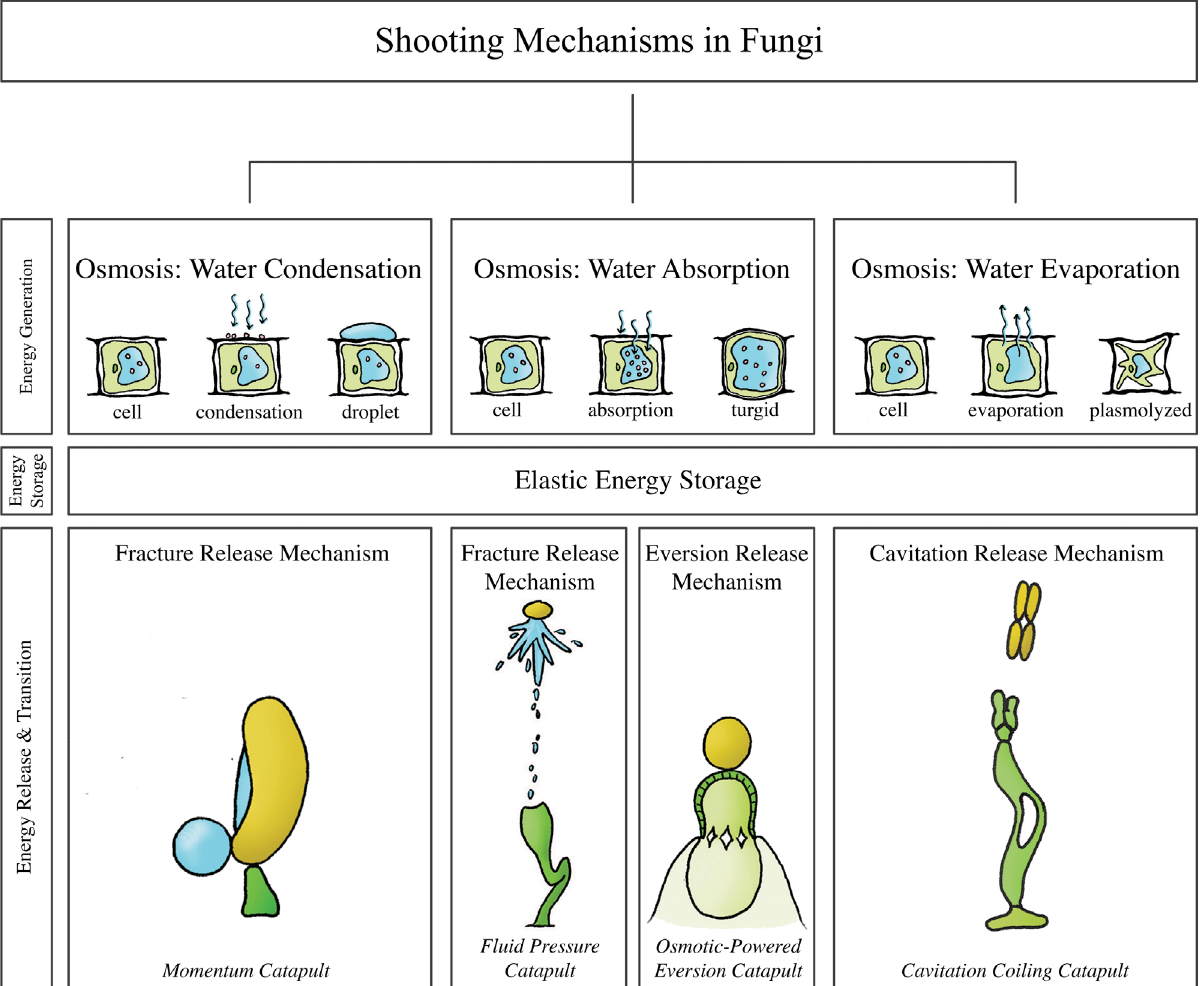
Fig 1. The structural categorization of the identified shooting mechanisms in fungi, allocated based on the energy management criteria discussed above. Momentum catapult : observed in the phylum Basidiomycota, schematic illustration of Auricularia auricular . Fluid pressure catapult : observed in the phylum Ascomycota and the genera Pilobolus and Basidiobolus of the phylum Zygomycota, schematic illustration of Pilobolus kleinii . Osmotic-powered eversion catapult : observed in the genus Sphaerobolus . Cavitation coiling catapult : observed in genera and species of the phylum Ascomycota and Basidiomycota, schematic illustration of Zygophalia jamaicensis